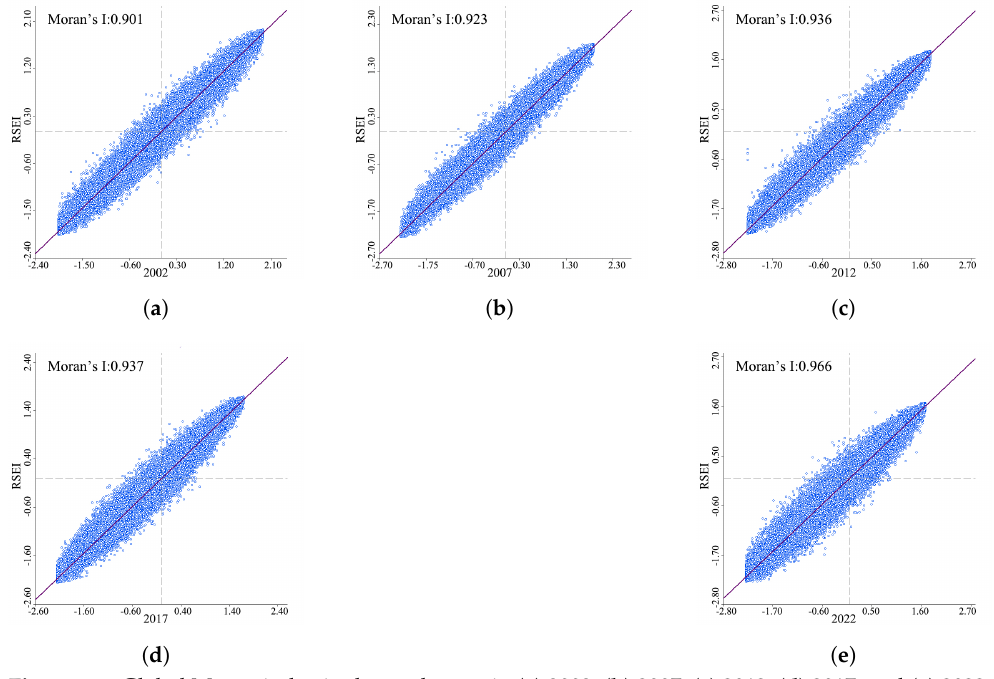
Figure 13. Global Moran index in the study area in ( a ) 2002, ( b ) 2007, ( c ) 2012, ( d ) 2017, and ( e )